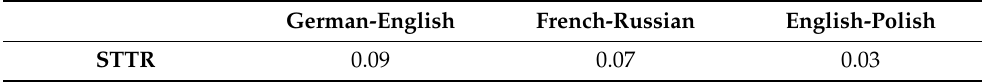
Table 4. The productivity of frames across the ANPs produced by the